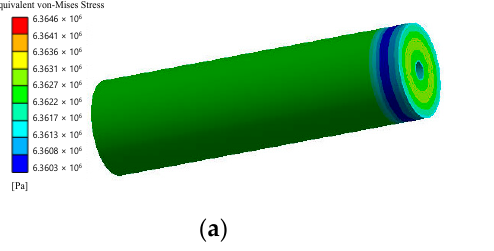
Figure 14. Equivalent stresses according to von Mises stress ( a ) and residual (plastic) relative linear strains ( b ) for composite with spherical filler at the moment of full compression (second stage).